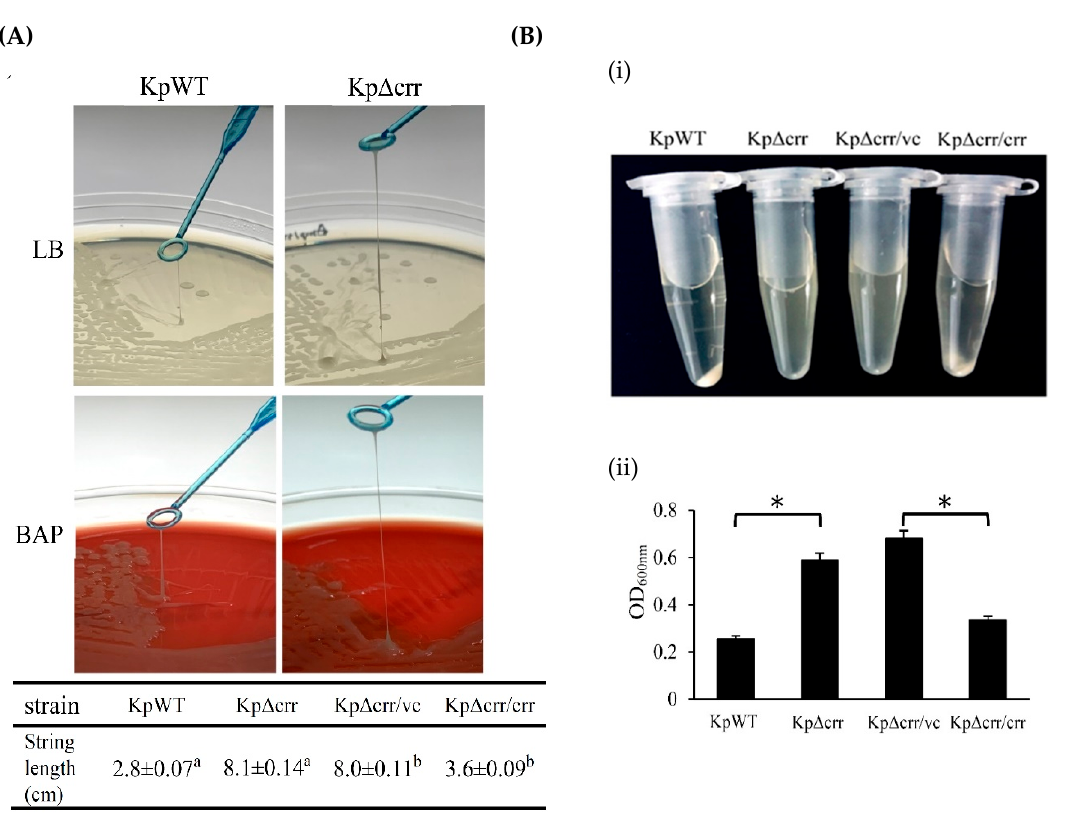
Figure 2. Deficiency of crr enhanced the mucoviscosity of K. pneumoniae . ( A ) Hypermucoviscosity phenotype observed by the string test. LB: LB agar plate. BAP: 5% sheep blood agar plate. ( B ) Bacterial mucoviscosity assay. (i) Image of bacterial culture after centrifugation. (ii) The absorbance of the supernatant was determined at 600 nm using a spectrophotometer. KpWT: K. pneumoniae STU1 wild-type. Kp ∆ crr: K. pneumoniae crr mutant. Kp ∆ crr/vc: K. pneumoniae crr mutant carrying pBAD33 (vector control). Kp ∆ crr/crr: K. pneumoniae crr mutant carrying pBAD33::crr ( crr complemented strain). The superscript a and b in ( A ) and asterisk ( ∗ ) in ( B ) represent p <